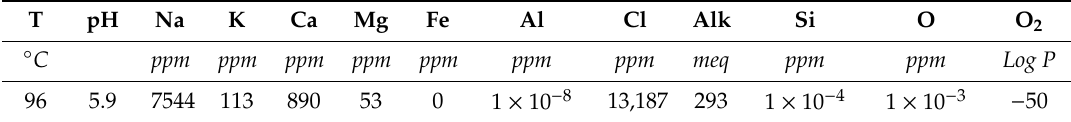
Table 1. Aqueous solution input for kinetic